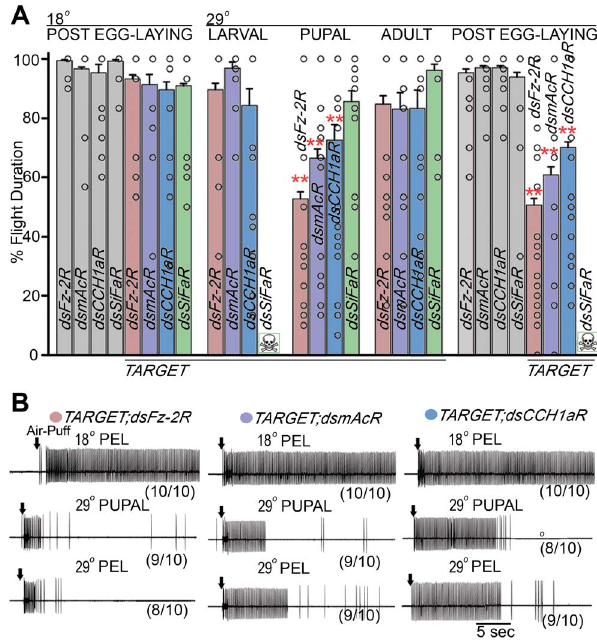
Figure 5. Adult flight deficits result from RNAi knockdown of specific GPCRs during pupal development. A ) Percentage flight time of RNAi heterozygotes (grey bars) and pan-neuronal knockdown of GPCR RNAi strains ( dsFz-2R in red, dsmAcR in purple, dsCCH1aR in blue, dsSIFaR in green) at specific developmental stages, as indicated above the bars using the GAL4/GAL80ts system ( TARGET ), are shown. Open circles within each bar represent percentage flight time for each fly. Mean flight times ( 6 SEM) were obtained for three batches of 10 tethered flies of each genotype after an air-puff stimulus. Pupal knockdowns at 29 u C were compared with the specific RNAi control at 18 u C; post egg-laying (PEL) knockdowns were compared with their specific RNAi controls (**P , 0.01, *P , 0.05; one-way ANOVA). B ) Electrophysiological recordings from the DLMs of air-puff stimulated tethered flies with pan-neuronal knockdown of RNAi ( dsFz-2R in red, dsmAcR in purple, dsCCH1aR in blue). The temporal stage at which knockdown was initiated is indicated above each trace. Numbers in brackets below each trace is the number of flies with the given response upon the number of flies tested. The remaining flies in each case showed a normal firing response. All flies maintained at 18 u C show rhythmic firing throughout flight. Flight pattern durations were reduced in flies either with pupal knockdowns (PUPAL 29 u C) or kept at 29 u C post egg-laying